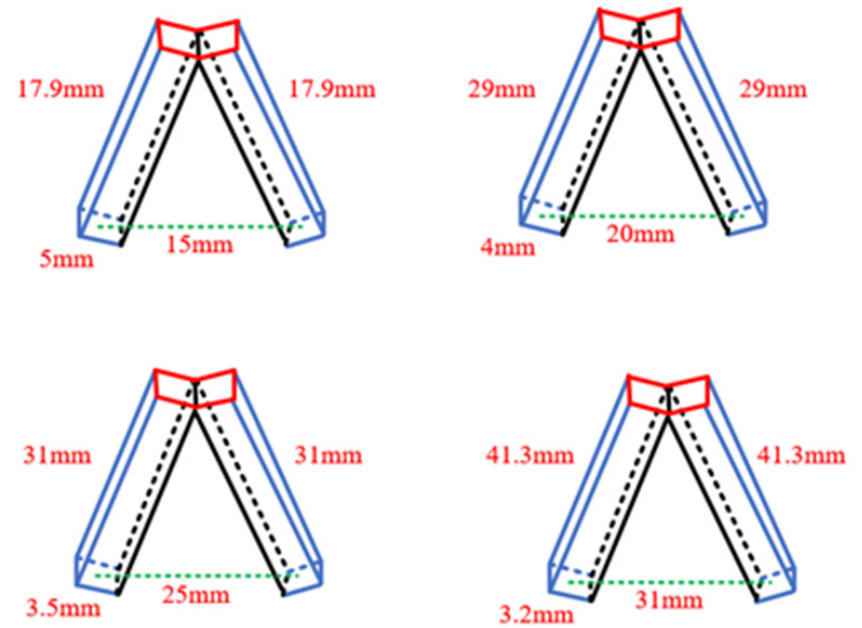
Figure 10. Schematic of the equivalent fire source of arc discharge with different gap distances in the simulation.